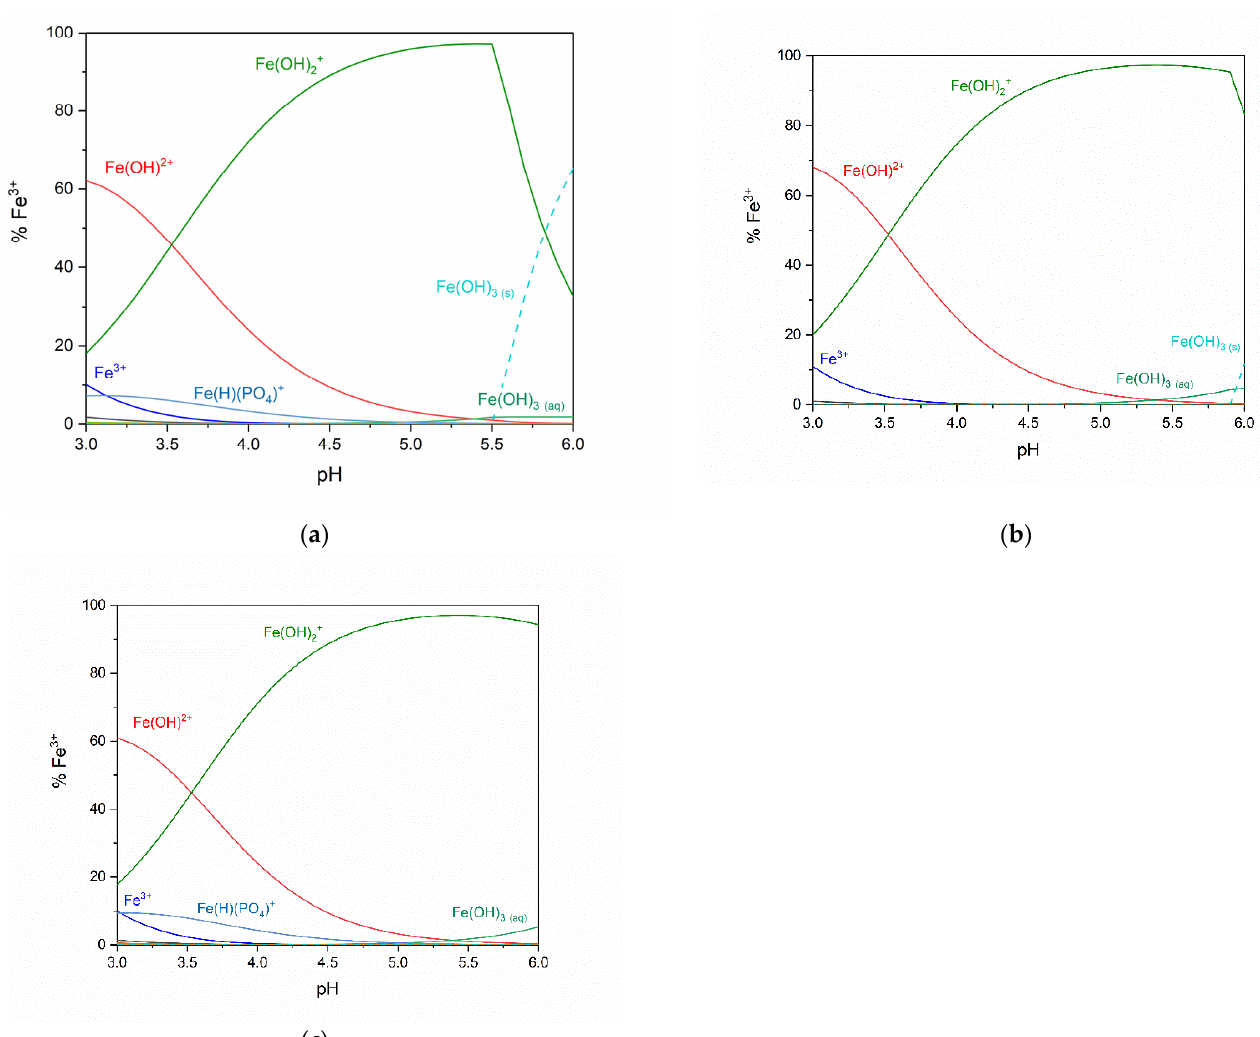
Figure 4. Species of Fe(III) occurring in the soluble fraction of the atmospheric deposition samples as a function of pH: ( a ) sample D1-1; ( b ) sample D5-1; ( c ) sample